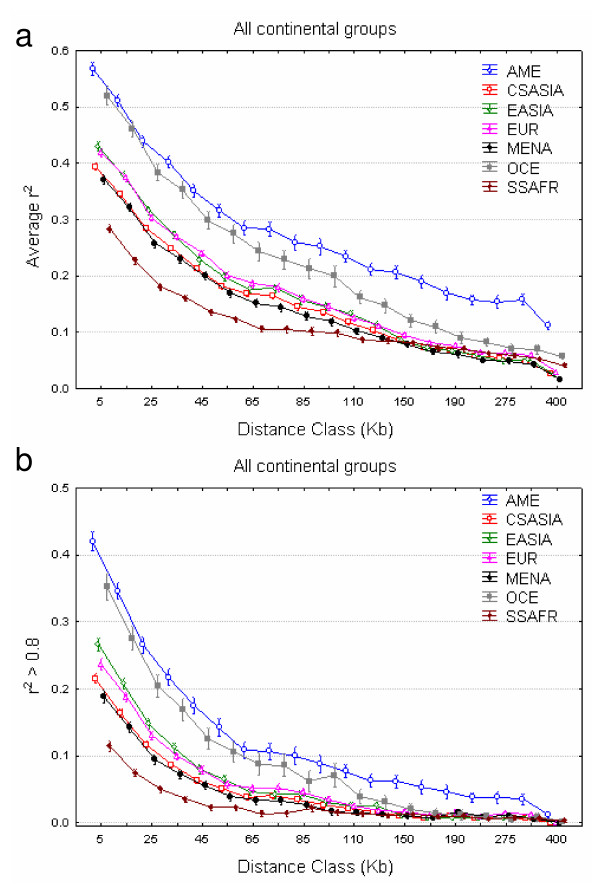
Continental decay of linkage disequilibrium. (A) Mean r2 between all possible SNP pairs within each gene region with MAF greater than 0.05 is plotted at the midpoint of each distance class. The X-axis is not to scale. (B) The proportion of SNP pairs with r2 greater than 0.8 is plotted at the midpoint of each distance class. Vertical lines represent 95% confidence intervals. The X-axis is not to scale. Continental regions are abbreviated as follows: Sub-Saharan Africa (SSAFR; including Bantu, Biaka Pygmies, Mandenka, Mbuti Pygmies, San, and Yoruba), Middle East-North Africa (MENA; including Bedouin, Druze, Mozabite, and Palestinian), Europe (EUR; including Adygei, Basque, French, North Italy, Orcadian, Russian, and Sardinian), Central South Asia (CSASIA; including Balochi, Brahui, Burusho, Hazara, Kalash, Makrani, North West China, Pathan, and Sindhi), East Asia (EASIA; including Cambodian, Han, Japanese, North East China, South China, and Yakut), Oceania (OCE; including NAN Melanesian and Papuan) and America (AME; including Colombian, Karitiana, Maya, Pima, and Surui).